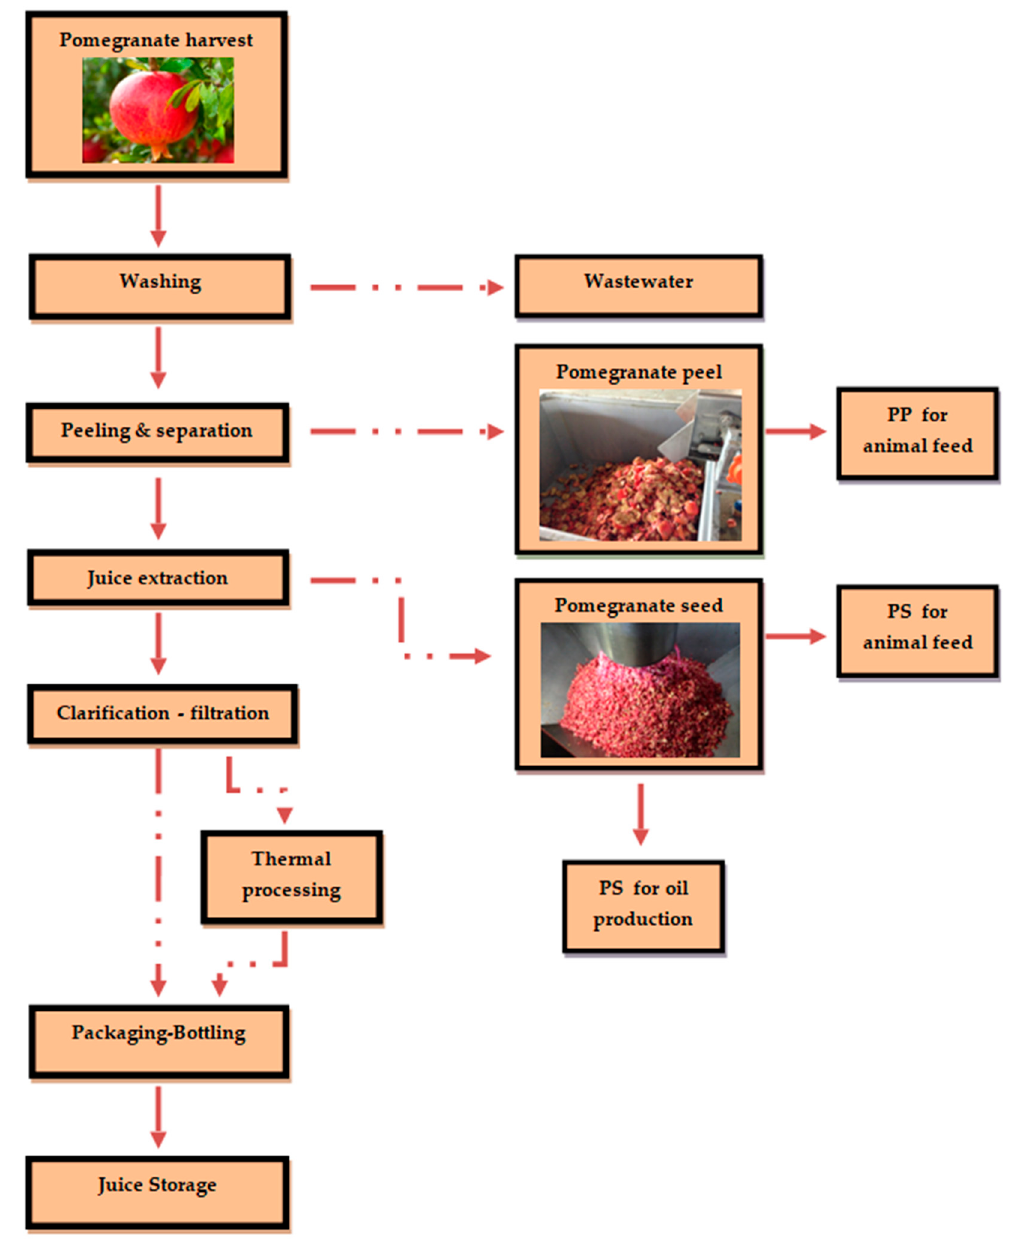
Figure 1. Schematic procedure of pomegranate juice and waste production.